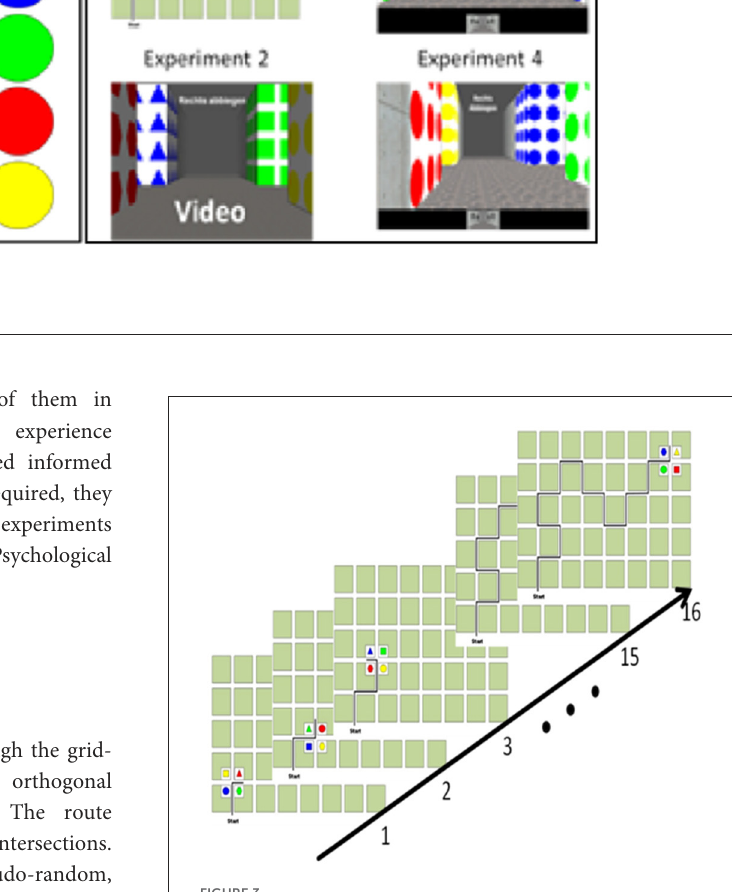
FIGURE3 Example of the street maps and the procedure of Experiment 1. For each decision point, participants had to select one of four route instructions each referring to one of the four landmarks at the